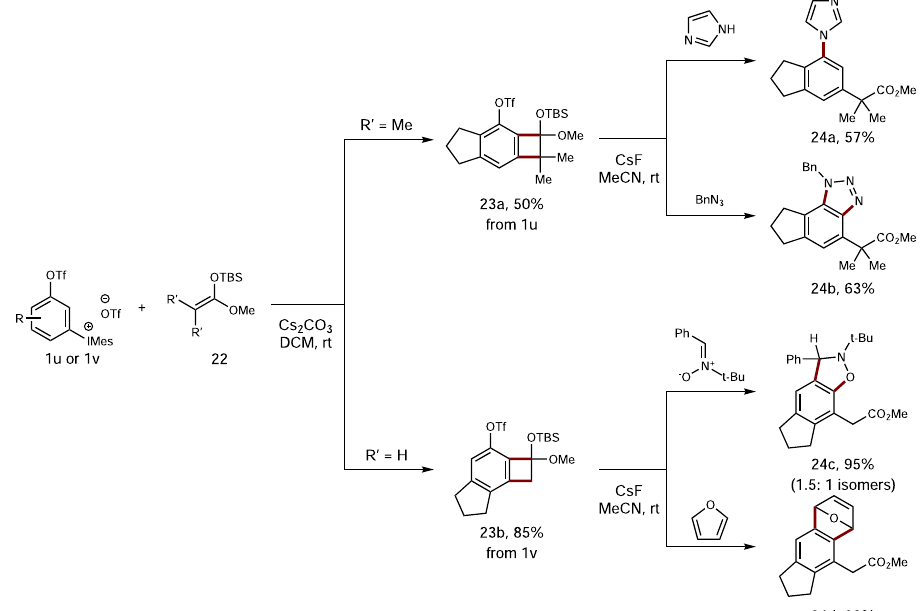
Fig. 7 | Manipulation through [2+2]-cycloaddition, Grob-fragmentation processes. All reactions are performed on a 0.4mmol scale. Isolated yields are given.